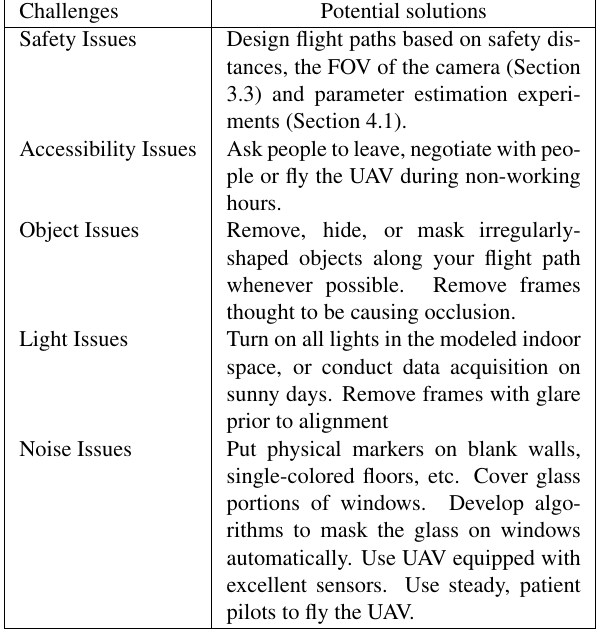
Table 2. Challenges in indoor UAV flight and potential solutions